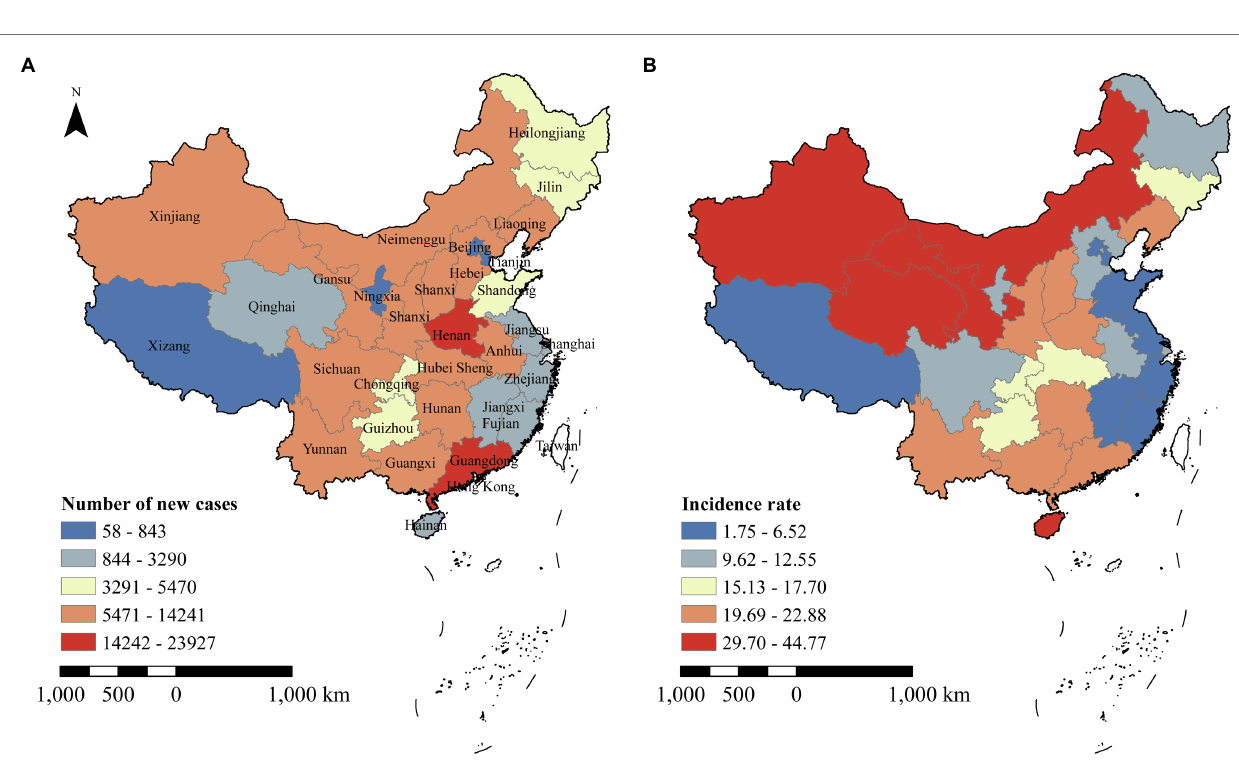
FIGURE 2 | Number of new cases and incidence of HCV infection reported in China in 2017. Plot (A) represents the HCV cases reported by China CDC in 2017. Plot (B) represents incidence rate calculated by the population of each province in